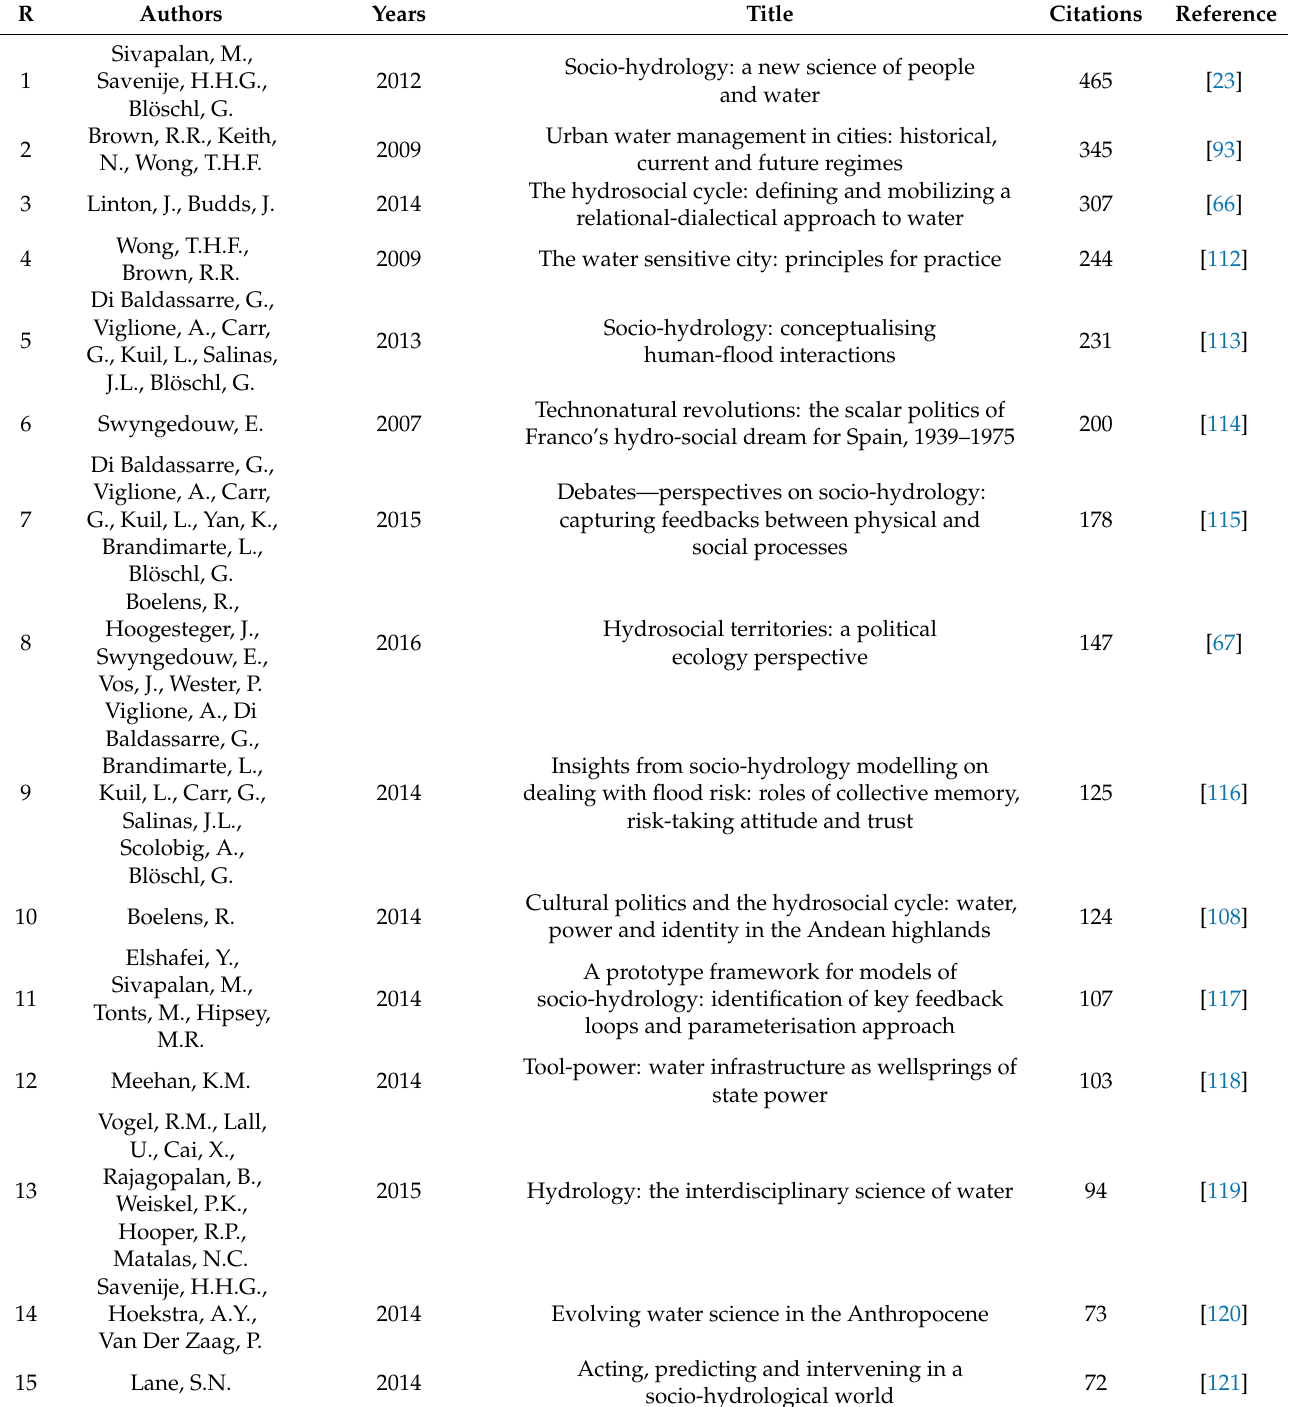
Table 3. Top 15 most cited